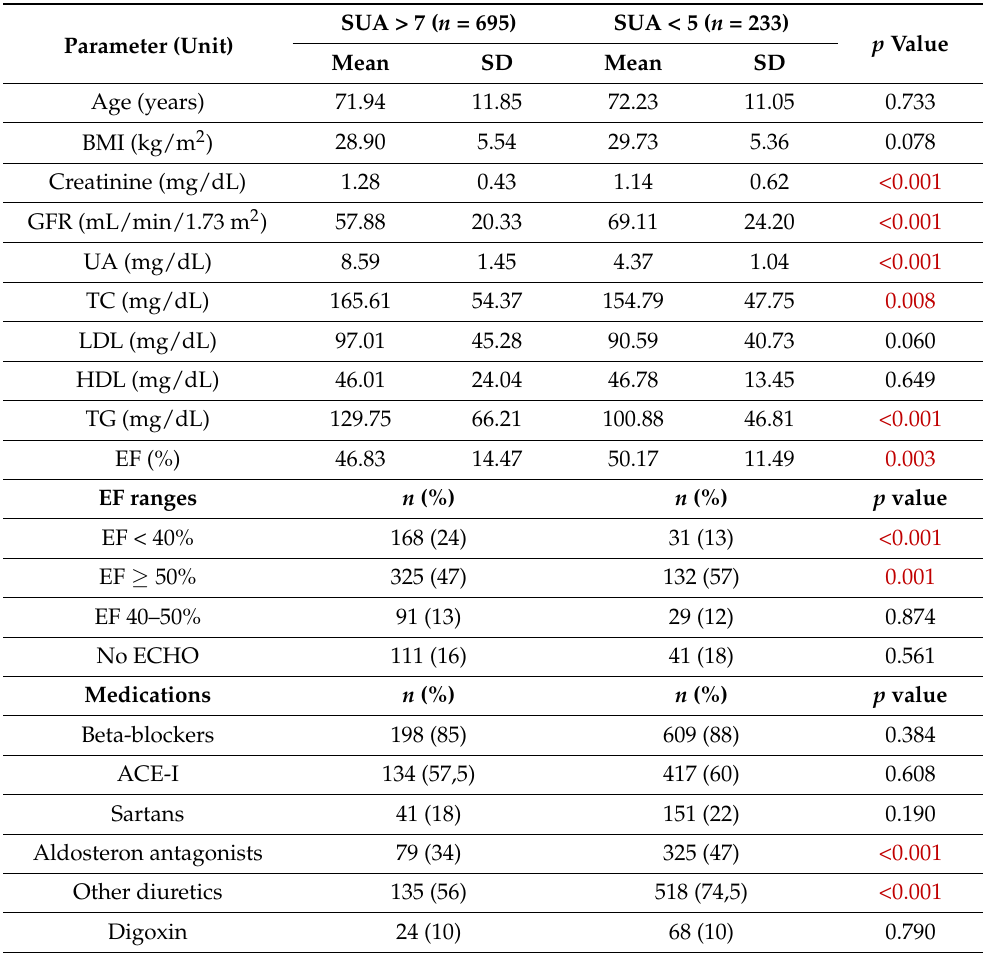
Table 2. Comparison of basic characteristics of subgroups with low (SUA < 5 mg/dL) and high (SUA > 7 mg/dL) uric acid